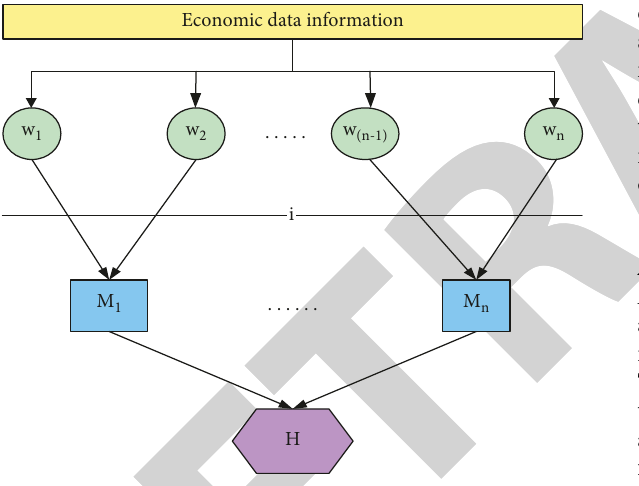
Figure 4: Economic data distribution